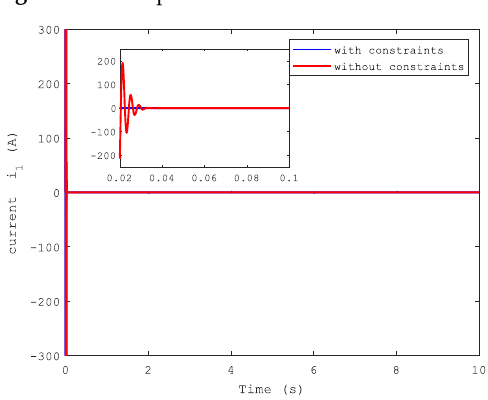
i Figure 9. Current i 1 1 i 1 i 1 i 1